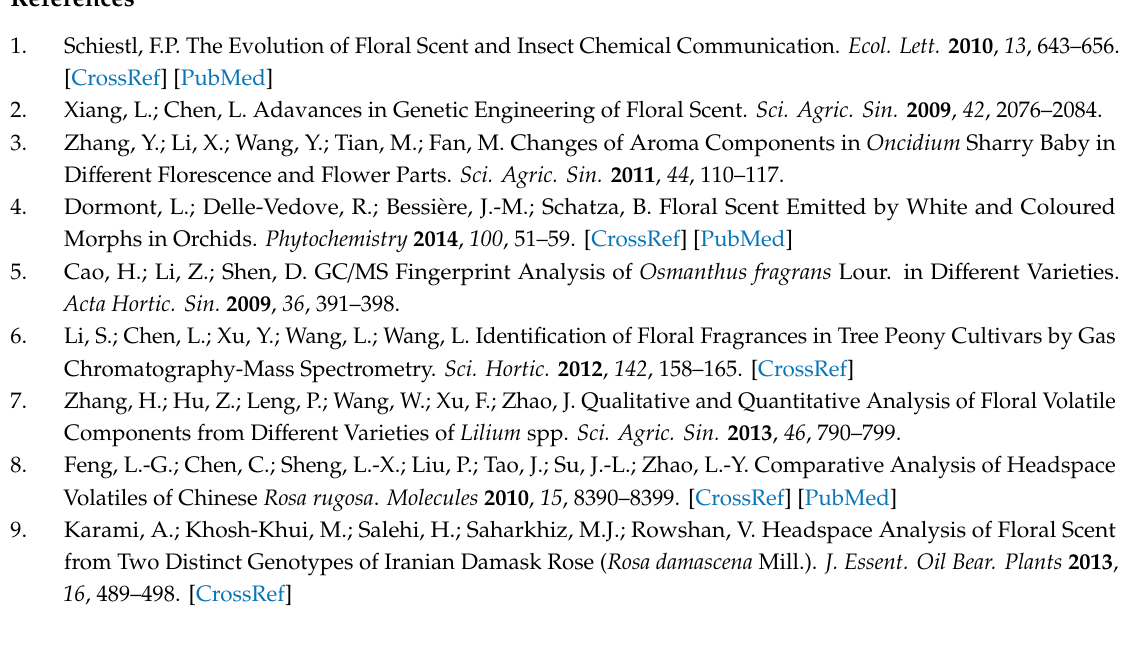
Supplementary Materials: The following are available online. Table S1: Loading matrix and Eigenvector values of the first 5 PCs, Figure S1: Total ionic chromatogram of scent components emitted from the flowers of twenty-seven accessions of three bearded iris